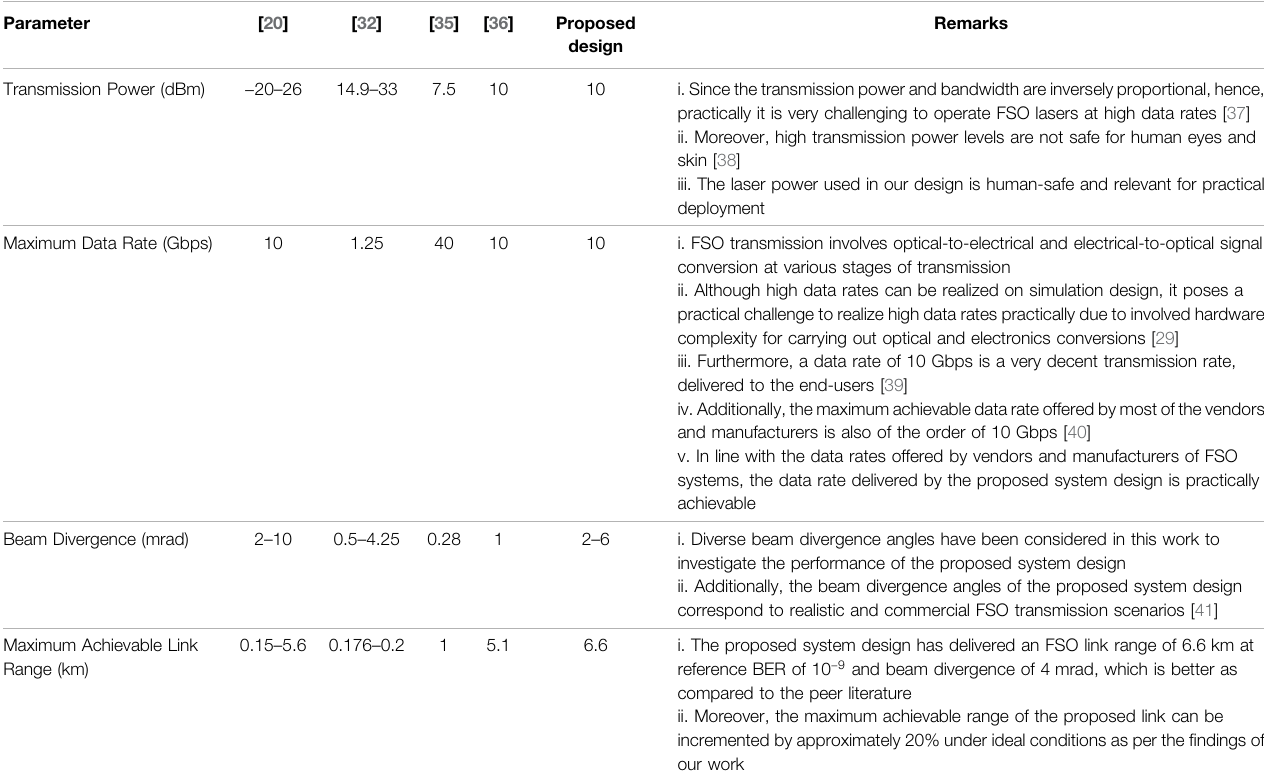
TABLE 4 | Comparison of proposed system design with previous